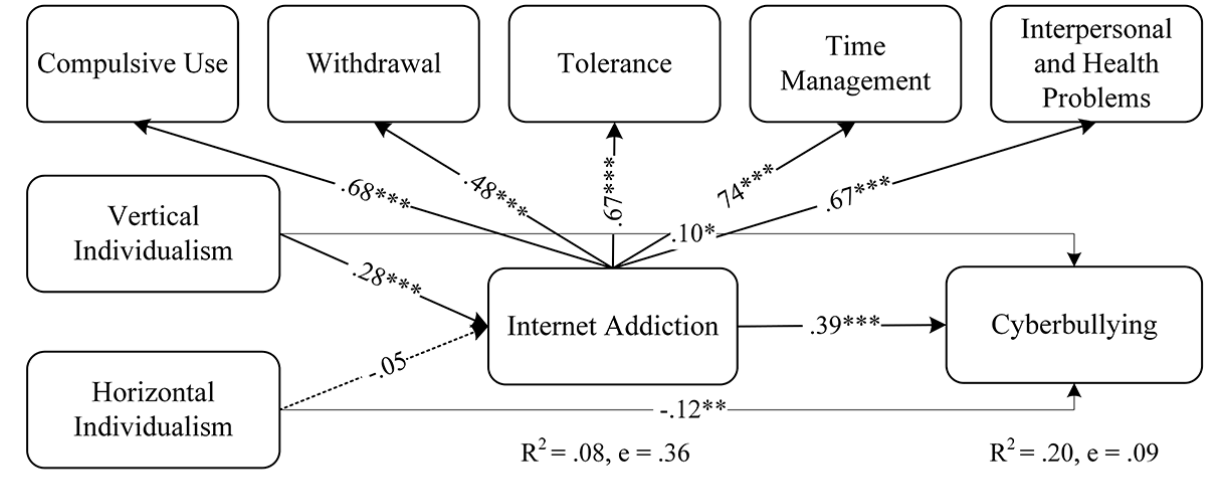
Figure 1. Relationships between vertical-horizontal individualism, cyberbullying, and internet